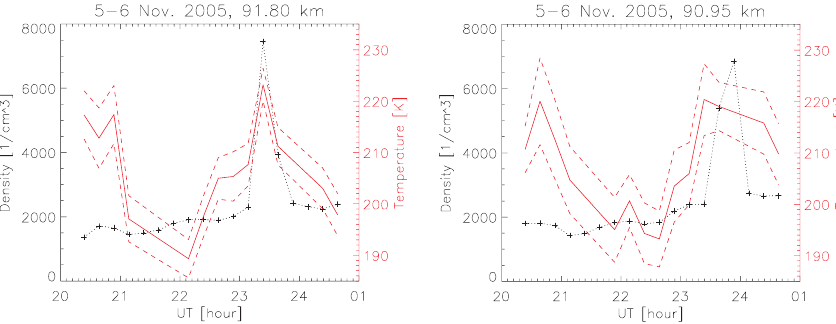
Fig. 8. 15min averaged densities and temperatures from the ALOMAR Weber Na lidar on 5–6 November 2005 at the height of maximum density increase. Beam 1 (left) is pointing 20 ◦ W of zenith. Beam 2 (right) is pointing 20 ◦ E of